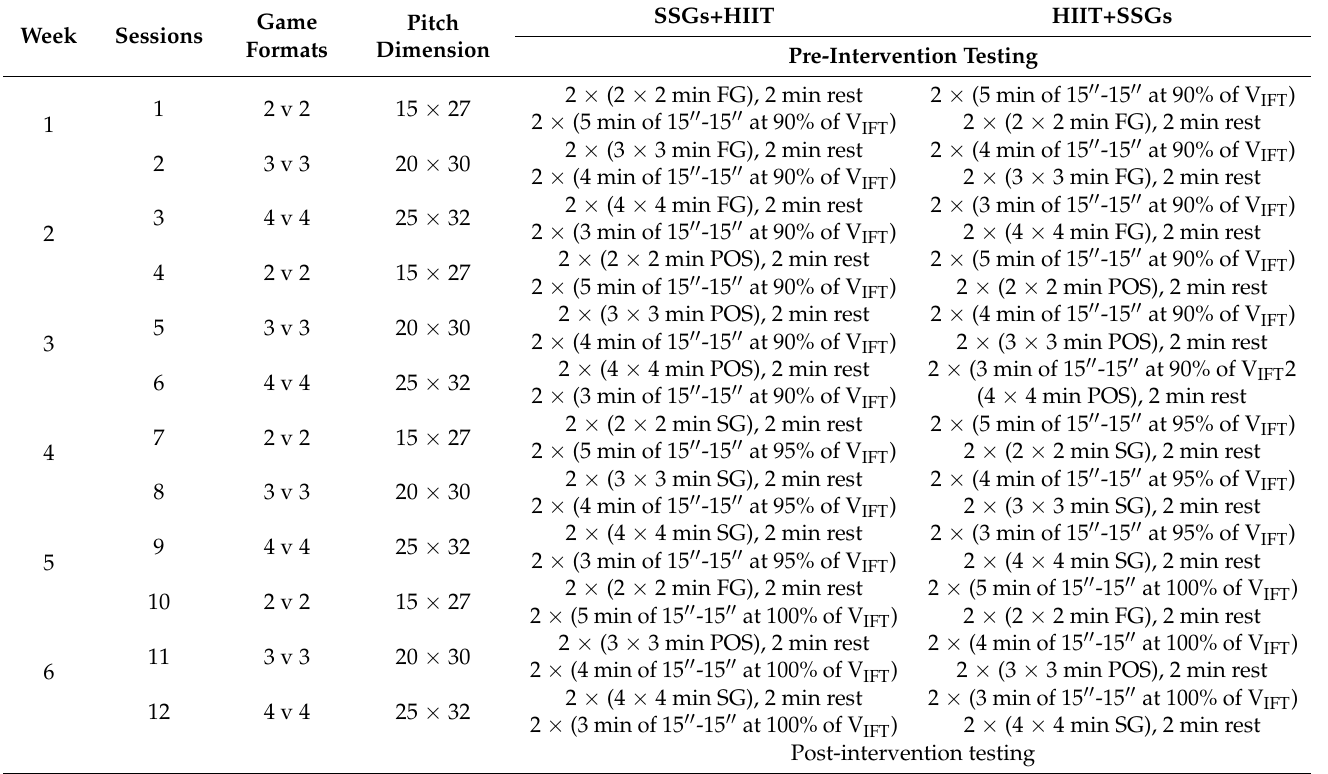
Table 1. Description of the 6 weeks of combined training